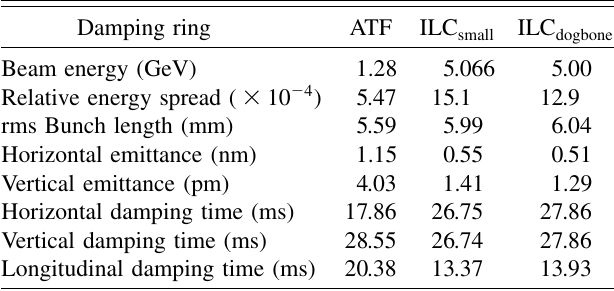
TABLE III. Nominal beam parameters for the ATF, ILC damping and ILC dogbone